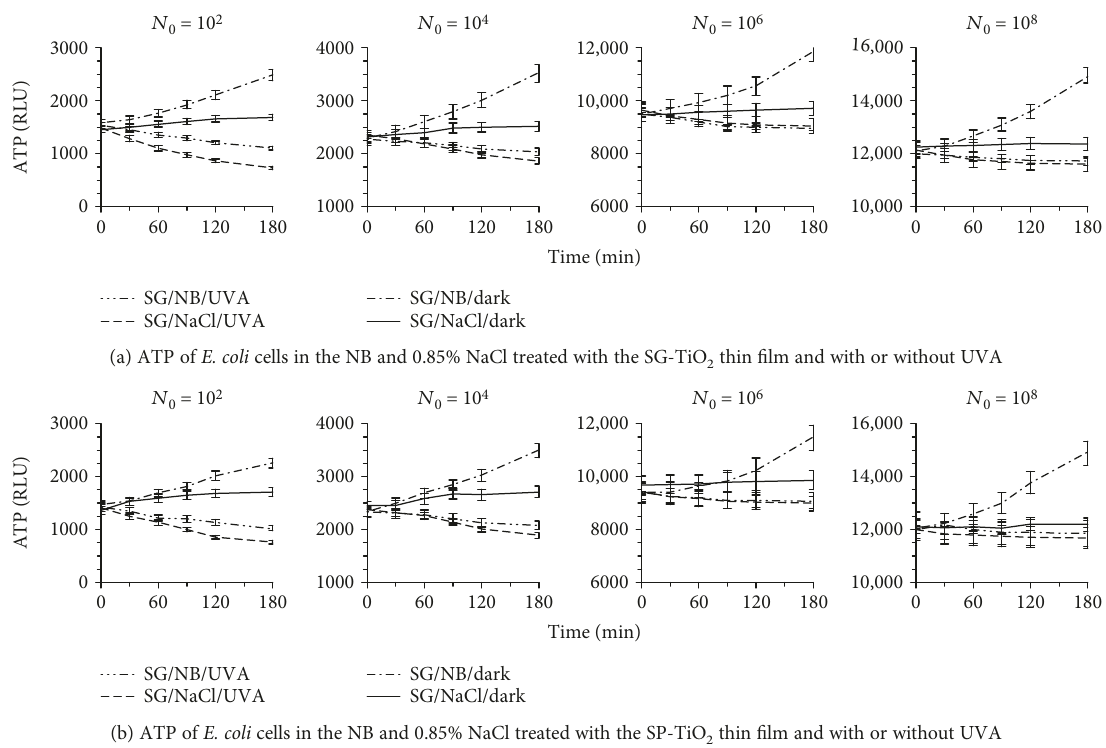
Figure 10: The ATP of E. coli cells treated with the experimental thin fi lms and with/without